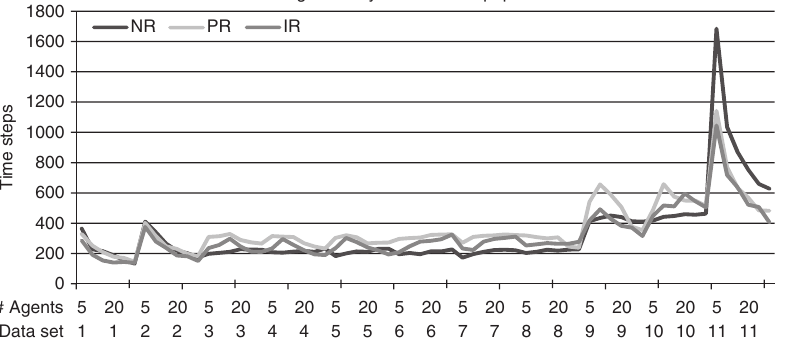
Figure 7. Average Time by Data Set, Population Size, and Recognition Type. On the horizontal axis, the top number refers to the population size and the lower number refers to the data set